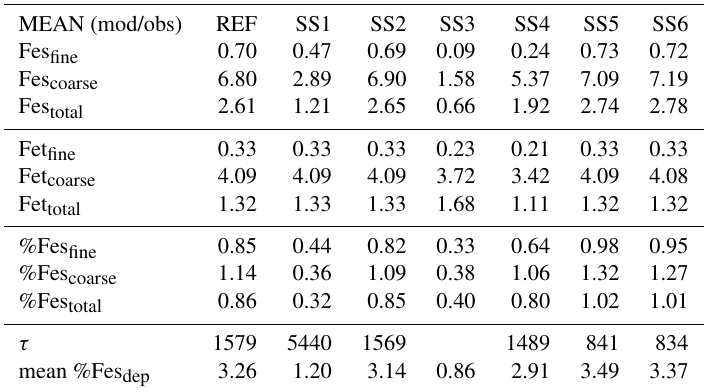
Figure 3. Observations (a) and modeled surface concentrations (b) of percent labile iron for particle diameter < 1µm. Scatterplot of observed fine-mode percent labile Fe versus modeled fine-mode percent labile Fe (c ). Red crosses indicate observations about 15 ◦ N, blue boxes indicate observations between 15 ◦ S and 15 ◦ N, and green diamonds indicate observations below 15 ◦ S. Grey vertical lines correspond to 1 standard deviation of model daily averaged concentrations between 2007 and 2011. Table 3. Mean of model at grid boxes with observations divided by the mean of the observations for the reference case (REF) and for sensitivity studies 1–6. In the last two rows, τ is the annually averaged global mean insoluble iron turnover time (days) and is defined as the total insoluble iron from dust and combustion aerosols divided by the production of soluble iron from insoluble iron. Mean %Fes dep is the annually averaged global mean fractional iron solubility at deposition